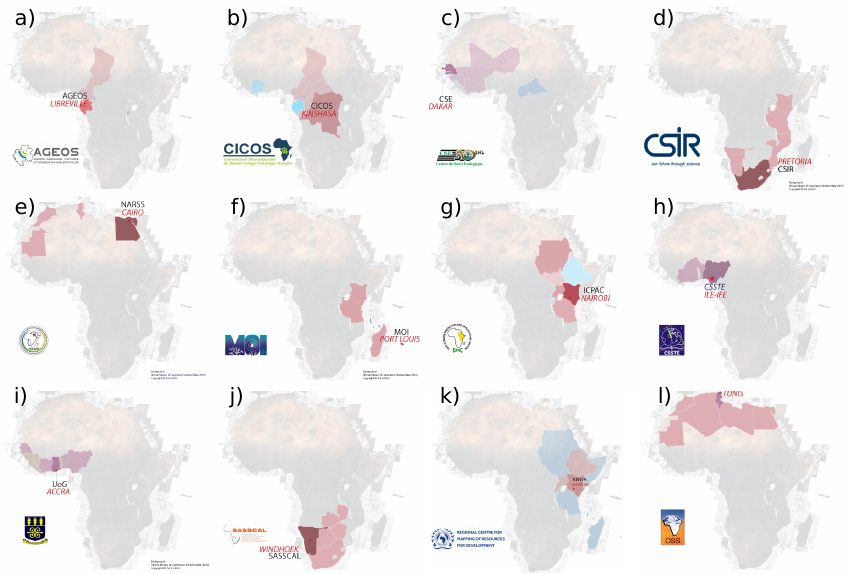
Figure 1. Map of the 12 consortia ( a – l ) involved in the GMES & Africa. For each consortia, a shaded region represents the countries associated and the name of the leader is indicated. The color indicates the status of the country representative (red for a partner and blue for a associate). Courtesy Brice Monfray